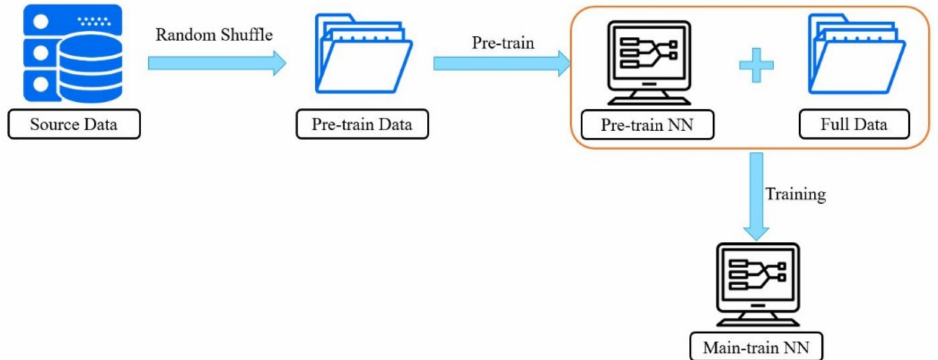
Figure 5. The random shuffle training